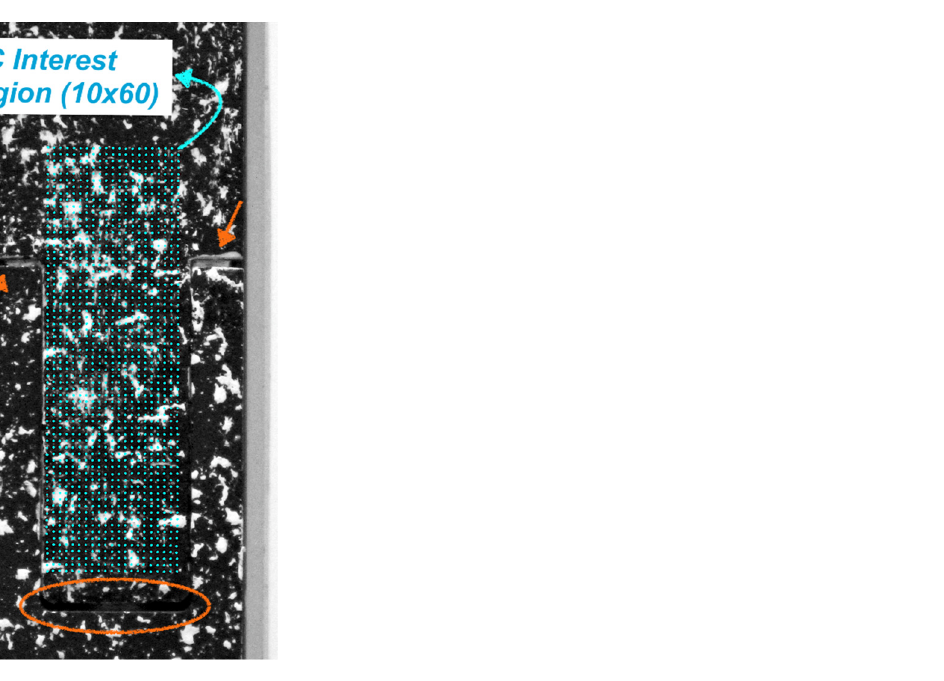
Figure 13. Detailed region of interest for digital image correlation (DIC) measurements and gap generation due to preload.